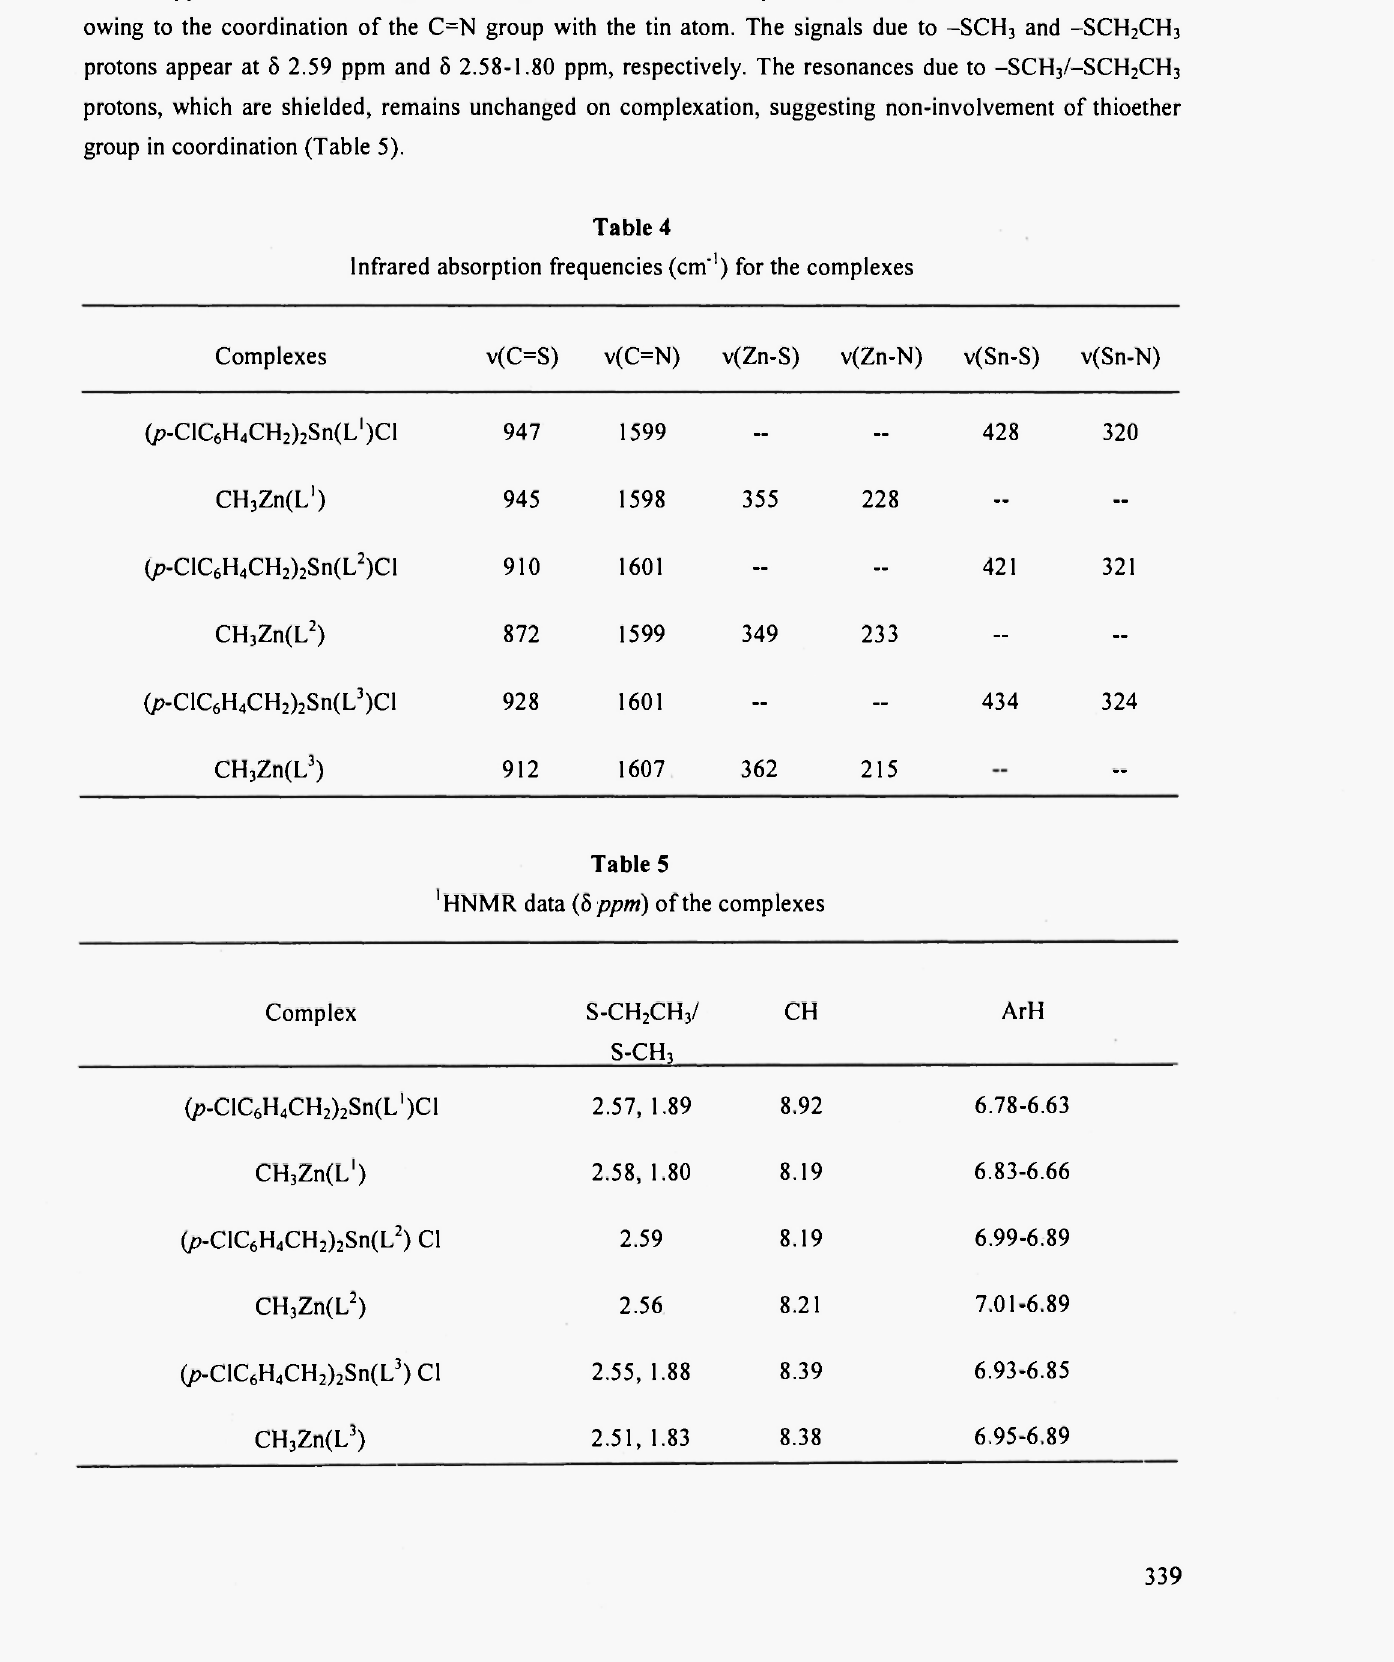
Infrared absorption frequencies (cm' 1 ) for the complexes